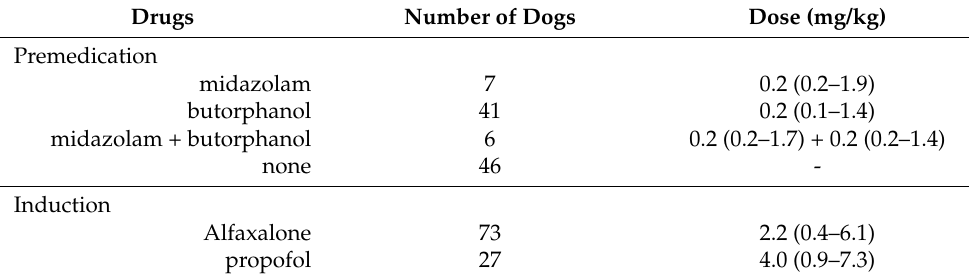
Table 1. Anesthetic and sedative drugs administered for anesthetic management. Drugs Number of Dogs Dose (mg/kg)